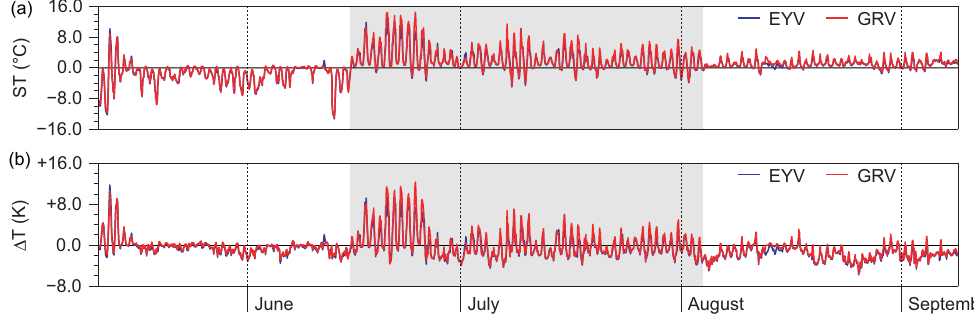
Figure 2. Records of measured hourly surface temperatures at the two ∼ 80mm tephra plots (a) and calculated differences between these surface temperatures and air temperatures measured at the automatic weather station (b) over 11 May to 8 September. The air temperatures are calculated as the mean of upper and lower air temperature sensor at the AWS. The types of tephra (EYV for Eyjafjallajökull volcano and GRV for Grímsvötn volcano) on which the surface temperatures were measured are indicated by color code. The grey shading in the center of the time series indicates the period considered in the final data set, i.e., 15 June to 3